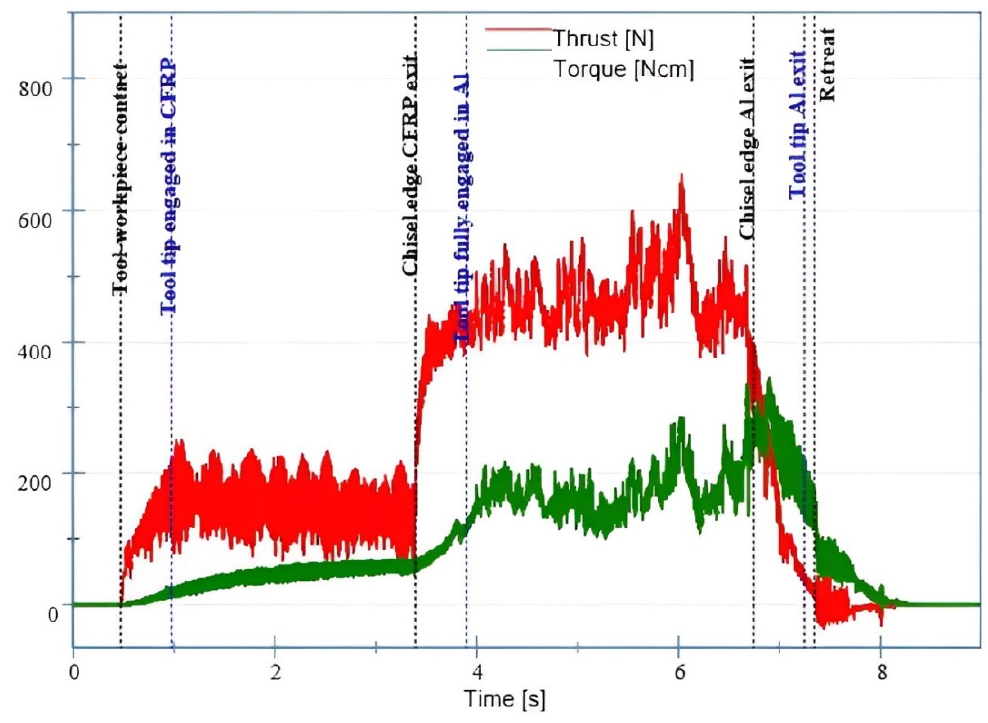
Figure 7. Thrust force evolution as a function of cutting time during the drilling of a CFRP/Al stack [123].